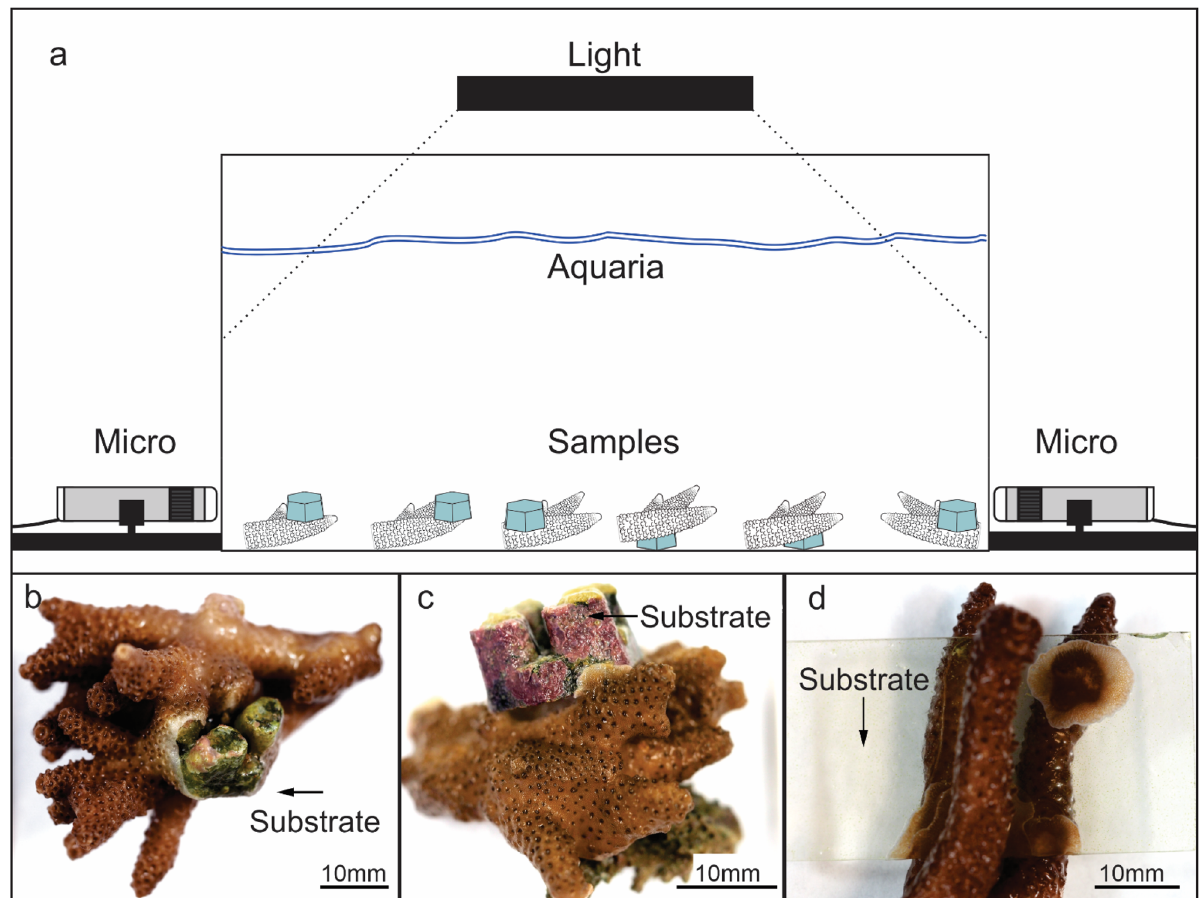
Figure 10. Digital graphic of the aquaria setup for the time-lapse and macro images of the ceramic clast and the glass substrate in the fragments. ( a ) The interface between the coral fragment tissue and the substrate was recorded (time-lapse) in a research aquaria setup with LED light for 30 days using light microscopes. ( b , c ) The ceramic substrate was placed either between the branches or at the surface/base of the fragment to maximise contact with both the higher growth areas and slower growth base tissues. ( d ) The glass substrate was lighter and less hydrodynamic than the ceramic, which made it easier to dislodge via water flow and therefore had to be placed between the branches for added